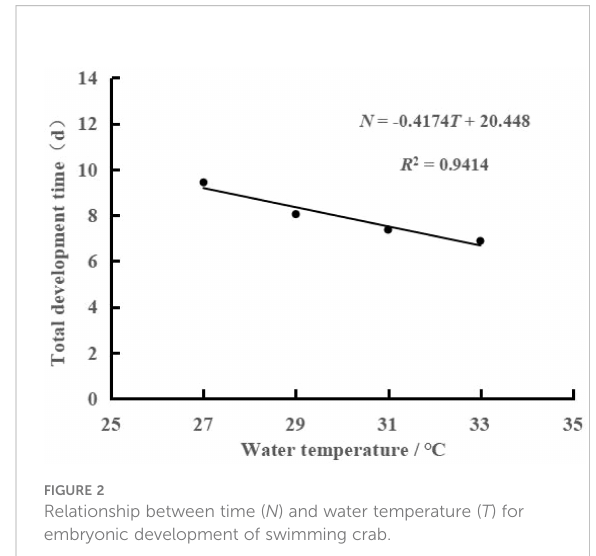
FIGURE 2 Relationship between time ( N ) and water temperature ( T ) for embryonic development of swimming crab.